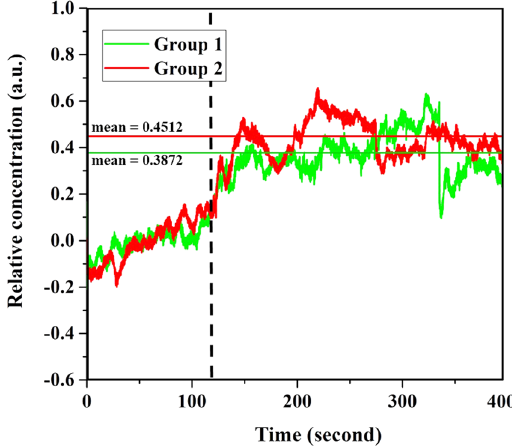
Figure 2. Oxyhemoglobin concentrations of Groups 1 and 2. The green line is Group 1. The red line is Group